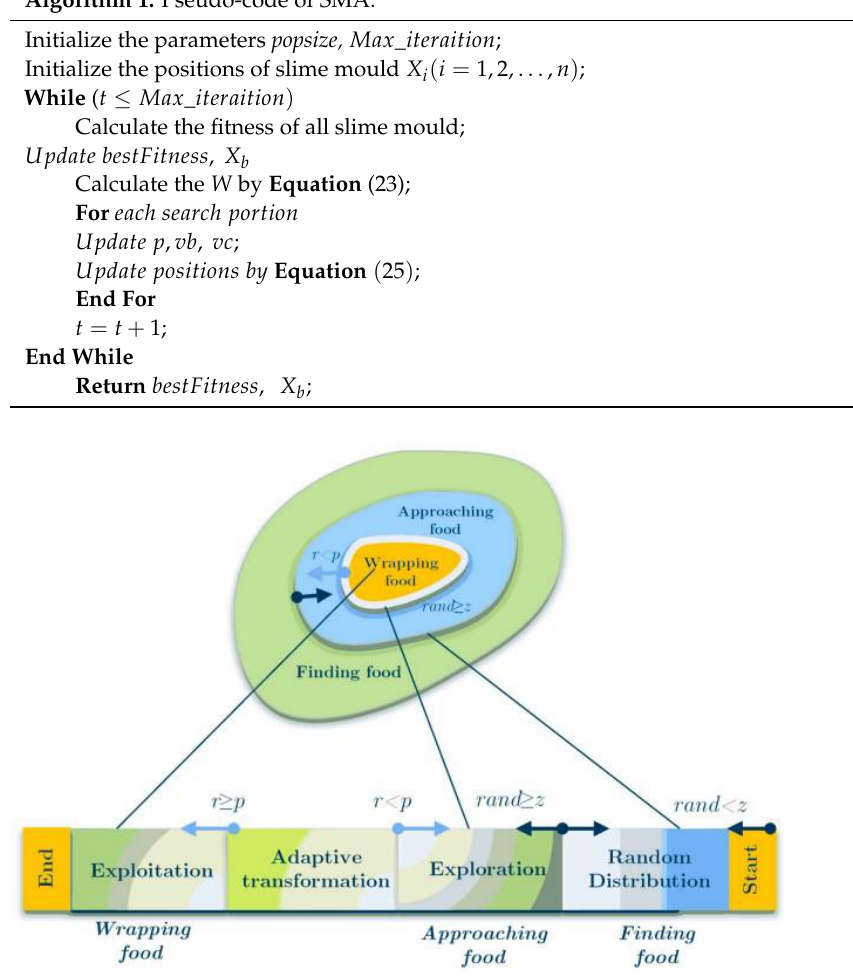
Figure 3. The overall steps of SMA